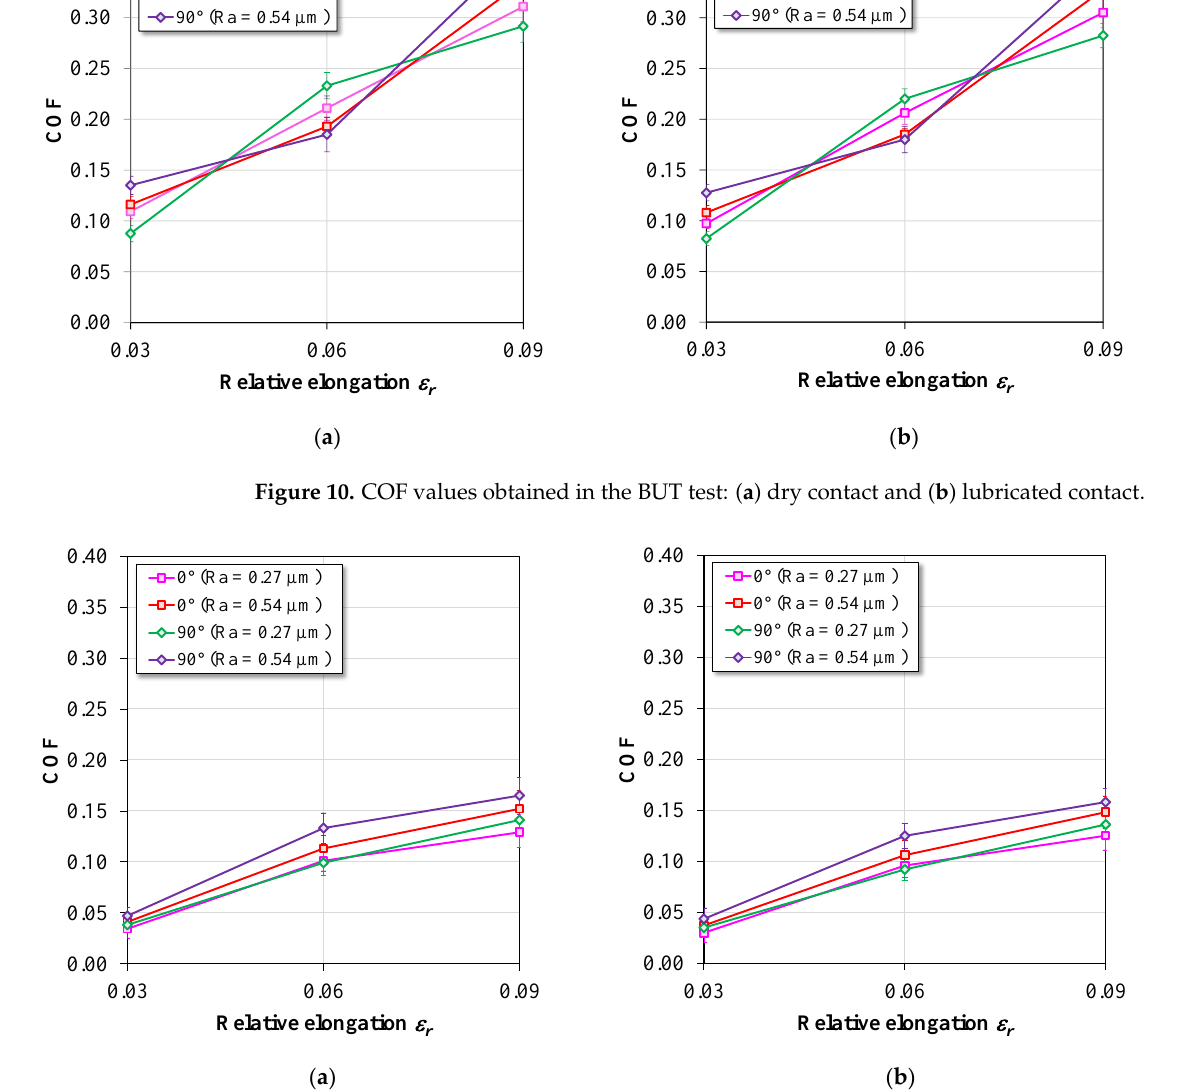
Figure 11. COF value obtained in the STT test: ( a ) dry contact and ( b ) lubricated contact.